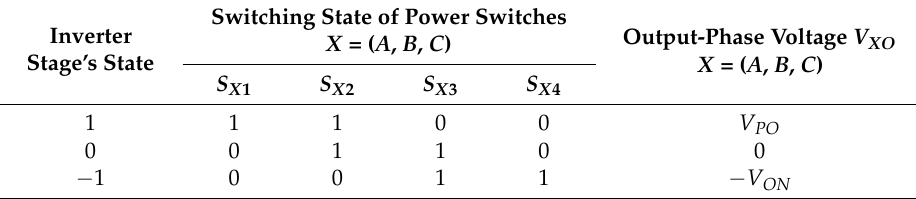
Table 2. The state of inverter stage and the output voltage according to the switching state.